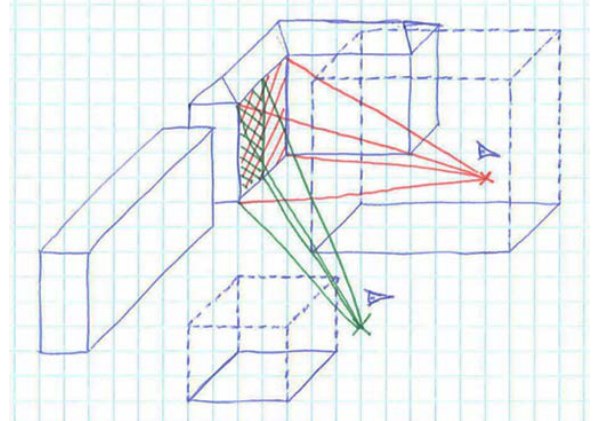
Figure 2: Viewing a façade from different